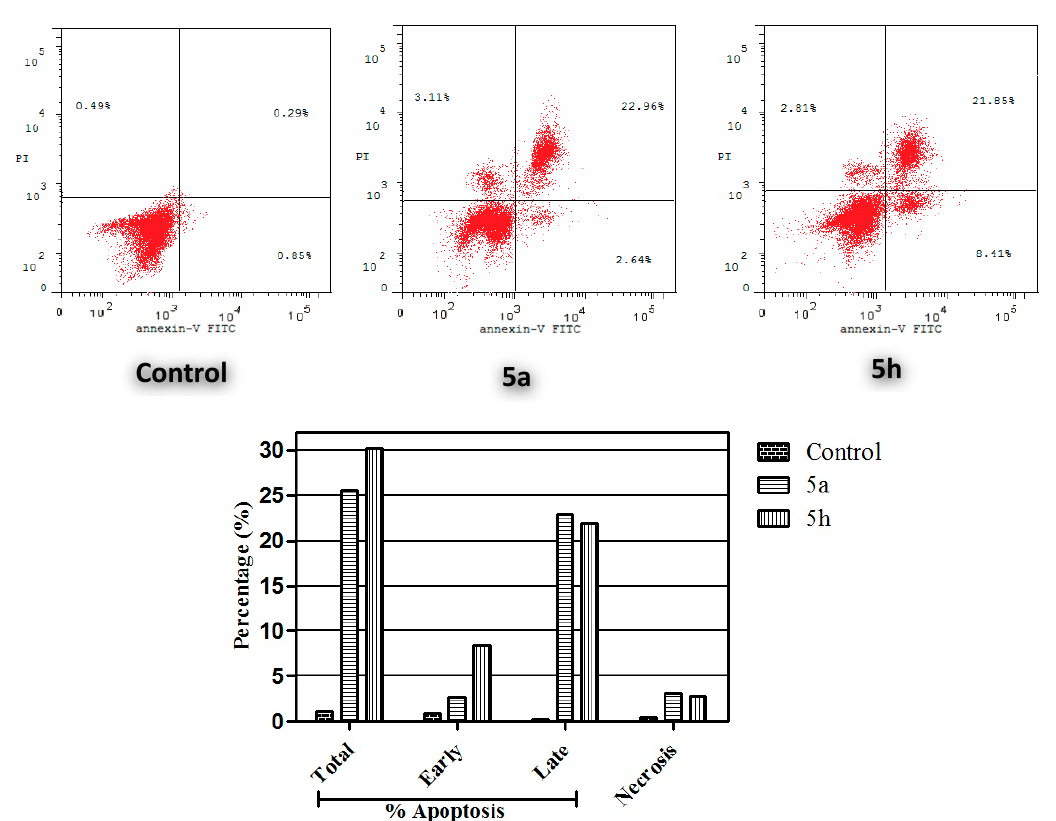
Figure 4. Effect of diamide-based benzenesulfonamides 5a and 5h on the percentage of annexin V-FITC-positive staining in UO-31 cells. The experiments were done in triplicates. The four quadrants identified as: LL, viable; LR, early apoptotic; UR, late apoptotic; UL, necrotic.